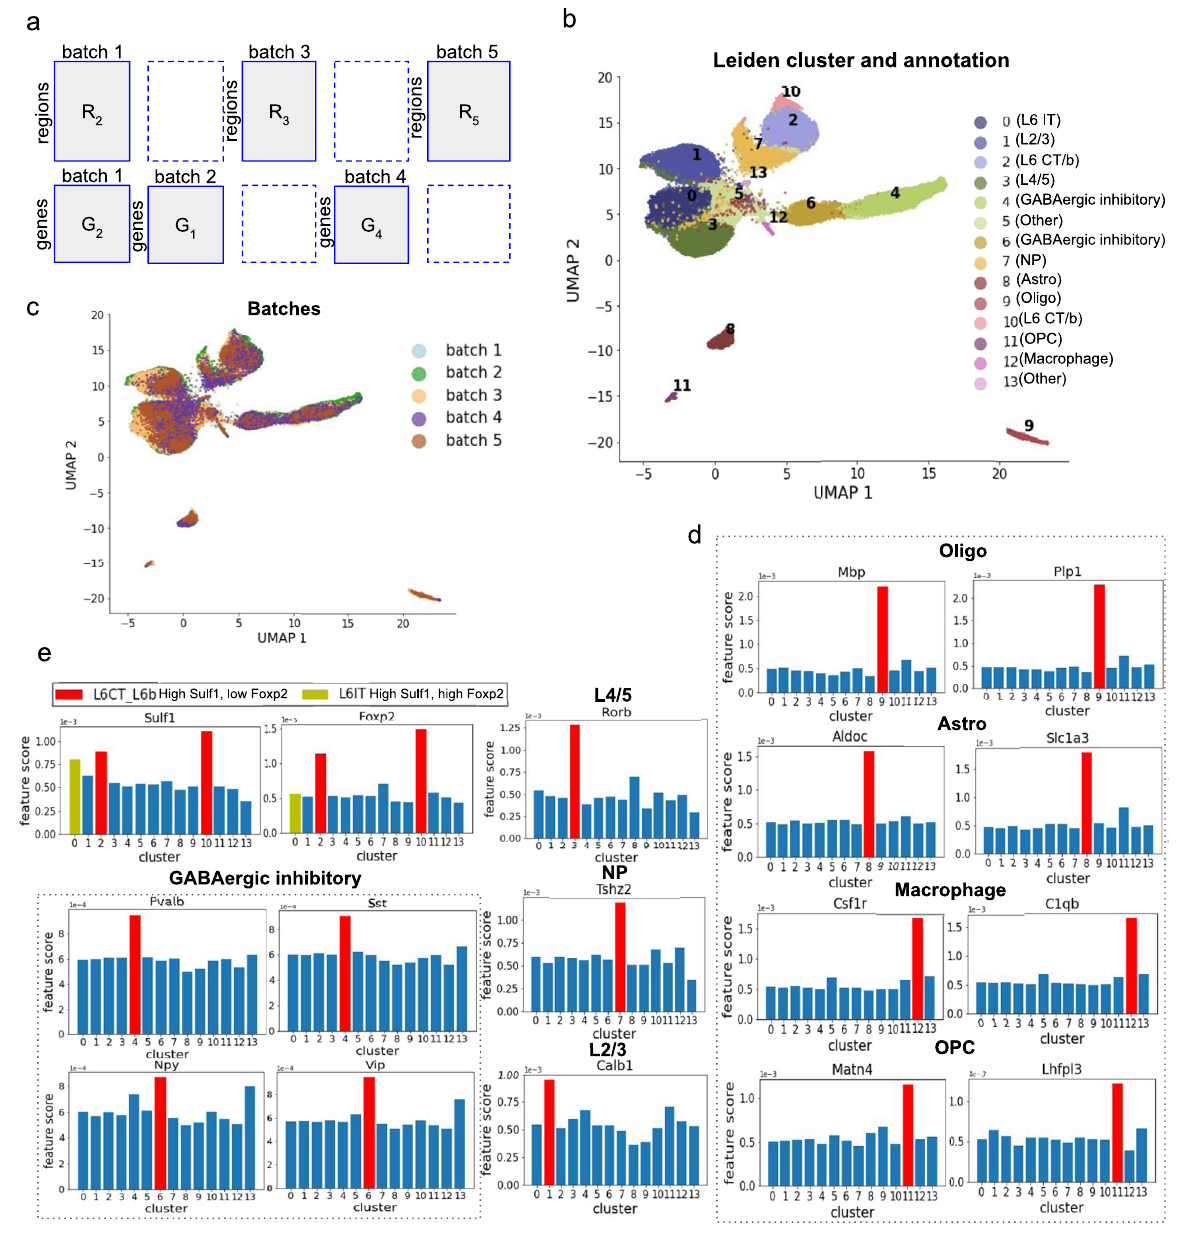
Fig.4|Resultsonmousebraincortexdataset.a Layoutofinputdatamatricesin mouse brain cortex dataset. The UMAP visualization of cell factors learned by scMoMaT, where cells are colored by b Leiden clusters (with scMoMaT-annotated cell types) and c cell batches. d The scores of marker genes for non-neuronal cell